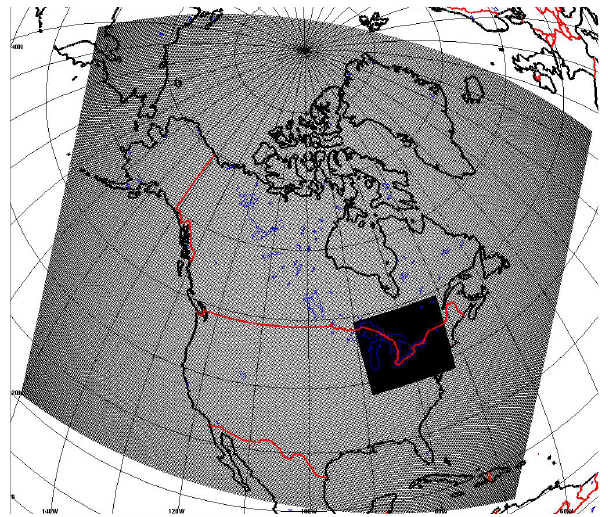
Fig. 1. GEM 15km (core portion of global-variable grid shown) and 2.5km domains.